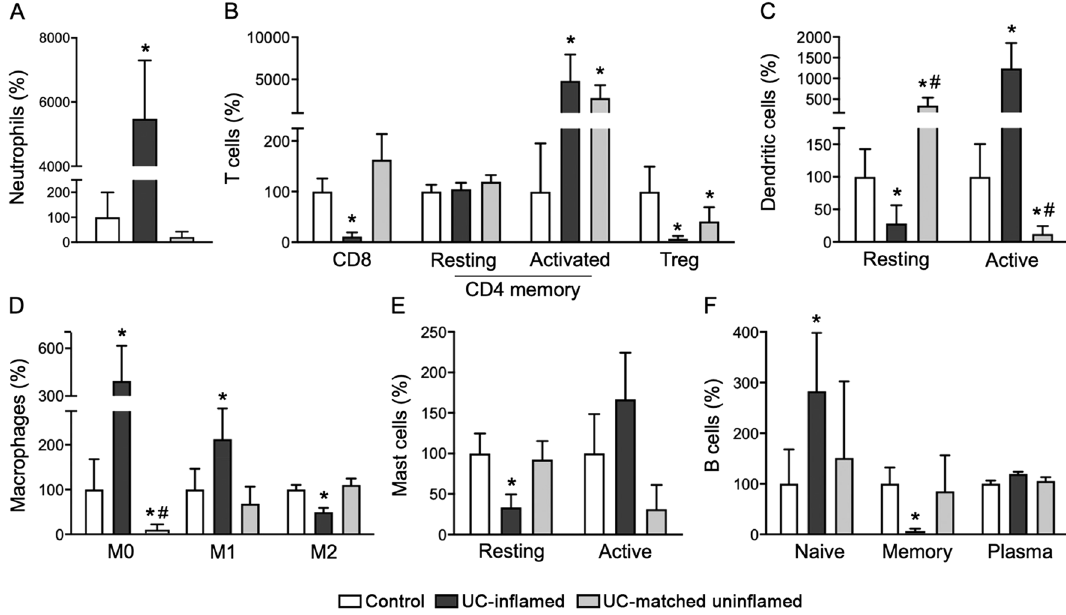
Figure 1. Alterations in immune cell profiles in UC inflamed and uninflamed matched tissue transcriptomes. CIBERSORT assessment of immune cell transcriptional signatures in transcriptomes of UC patients from inflamed or matched uninflamed tissue compared to healthy control. Immune cell signatures represent neutrophils ( A ) subsets of T cells ( B ), DC ( C ), macrophages ( D ), mast cells ( E ) and B cells ( F ) (GSE38713) (n = 13 healthy control, n = 15 UC-inflamed, n = 7 UC-matched uninflamed; CIBERSORT, * # p < 0.05; *vs. Con, # vs.